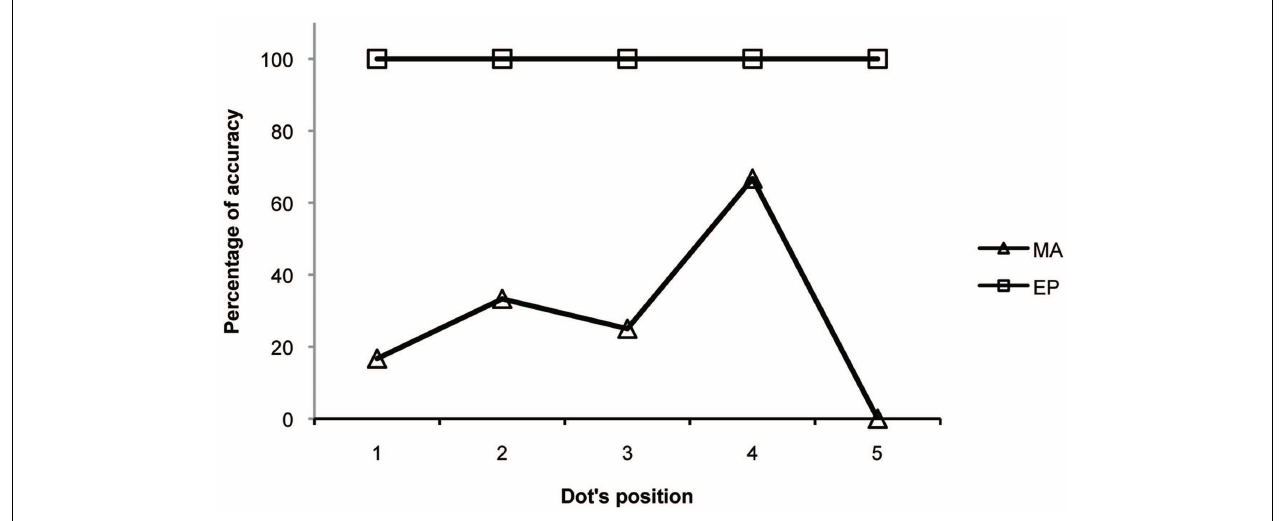
FIGURE 3 |The mean percentage accuracy in a non-verbal saccadic task (following a dot moving from left to right and from right to left) made by the two patients .